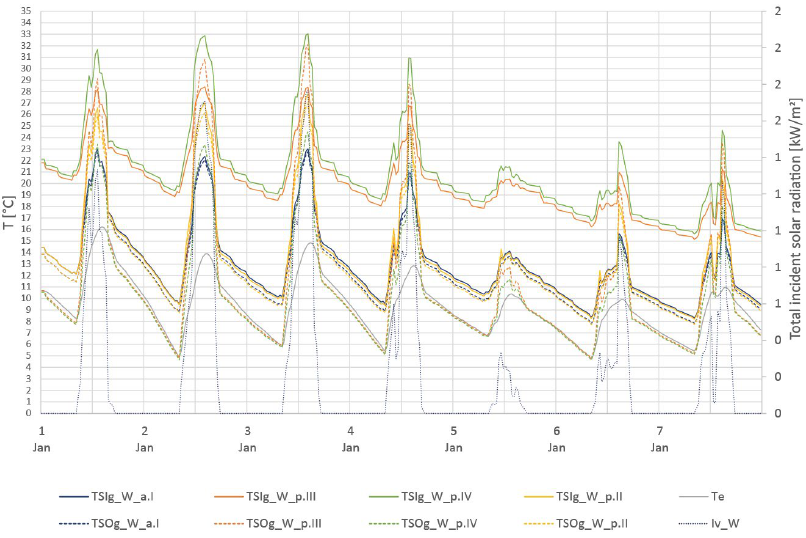
Figure 12. Surface temperature for different glazing systems North-West oriented; winter period: January, first week (floor 2).